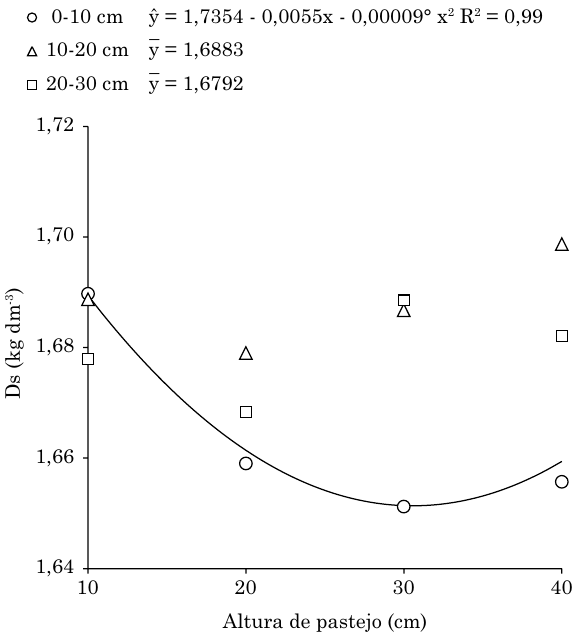
Figura 1. Densidade do solo (Ds) em três camadas do solo (0-10, 10-20 e 20-30 cm) de pastagem de Urochloa ruziziensis em função das alturas de pastejo (10, 20, 30 e 40 cm). º: significativo com